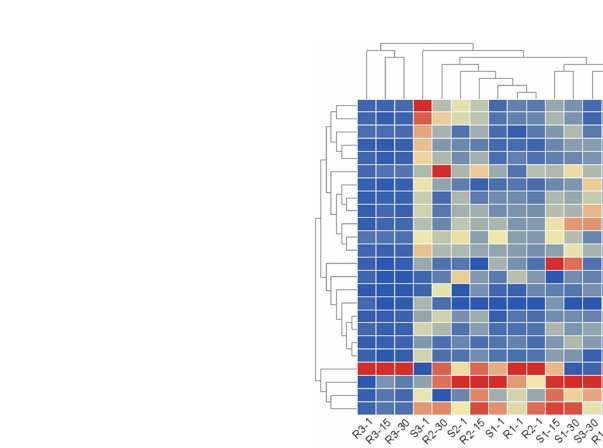
map (Figure 2) results and weighted gene co-expression network analysis of the transcriptome, 22 candidate PmRLK genes were identi fi ed (Supplementary Figure S1).